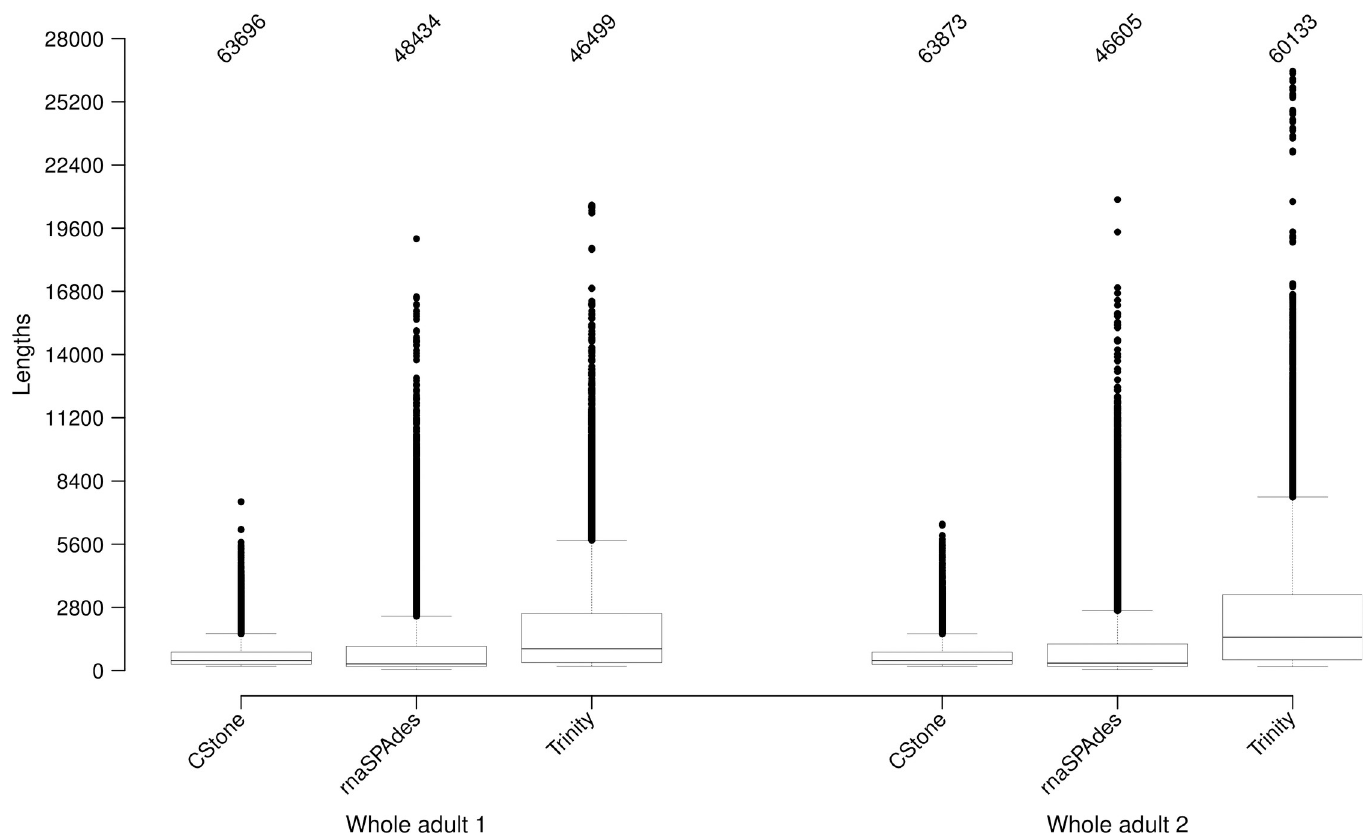
Fig 10. Overall length of contigs produced on real data. On the x-axis the dataset source along with the sample is identified. The numbers on the top indicate the total number of sequences present. Values covered by box and whiskers are the same as those described for Fig 4. The numbers of contigs above 5000 nt in length are indicated within Table 5.